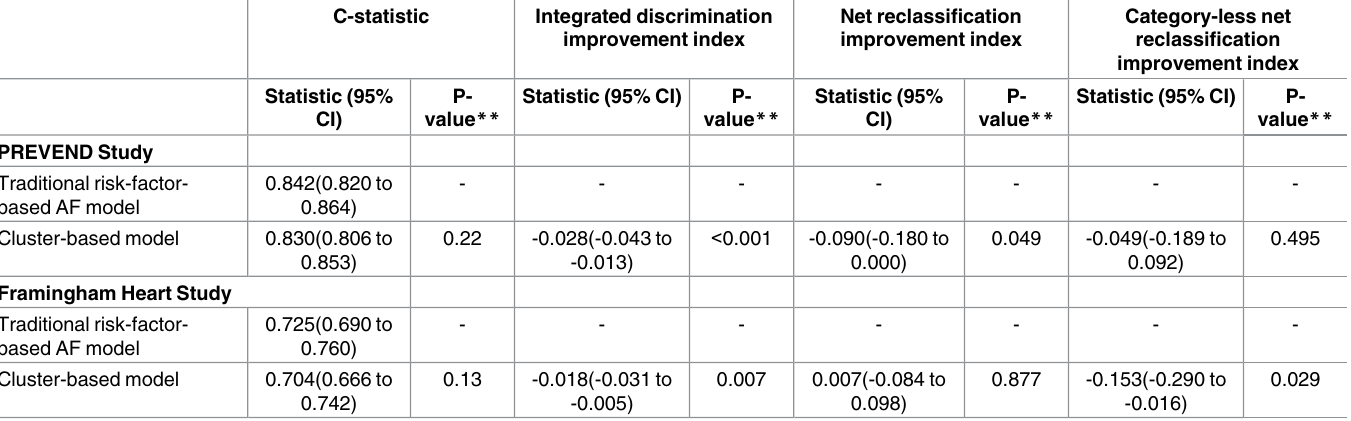
Table 3. Discrimination and reclassification performance of latent class clustering models and comparison with traditional risk-factor-based AF prediction model *